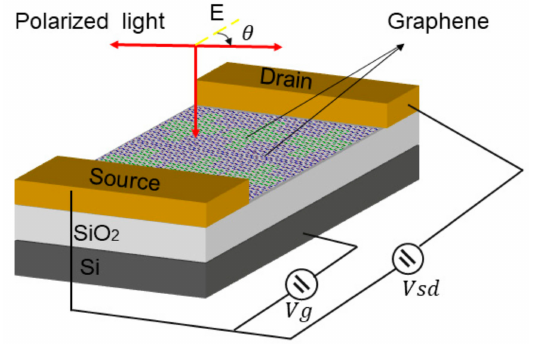
Figure 10. Schematic of graphene photodetector. The angle θ stands for polarization